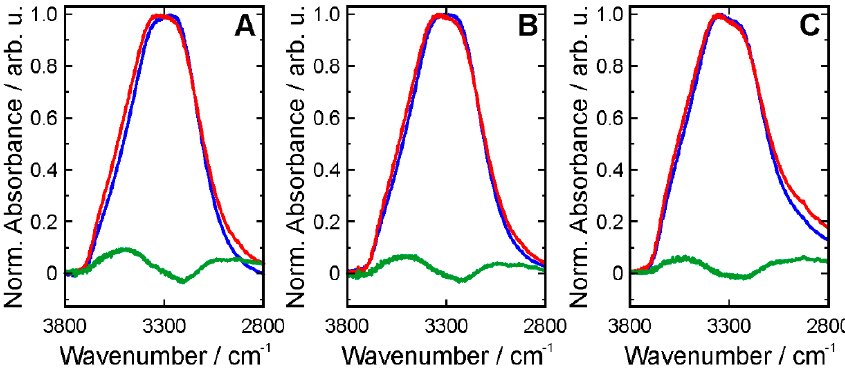
Figure 3. Normalized spectra (color code as in Figure 2) and difference spectra (green) in the OH stretching region. ( A ): water; ( B ): aqueous sodium sulfate solution; and, ( C ): aqueous citric acid solution.